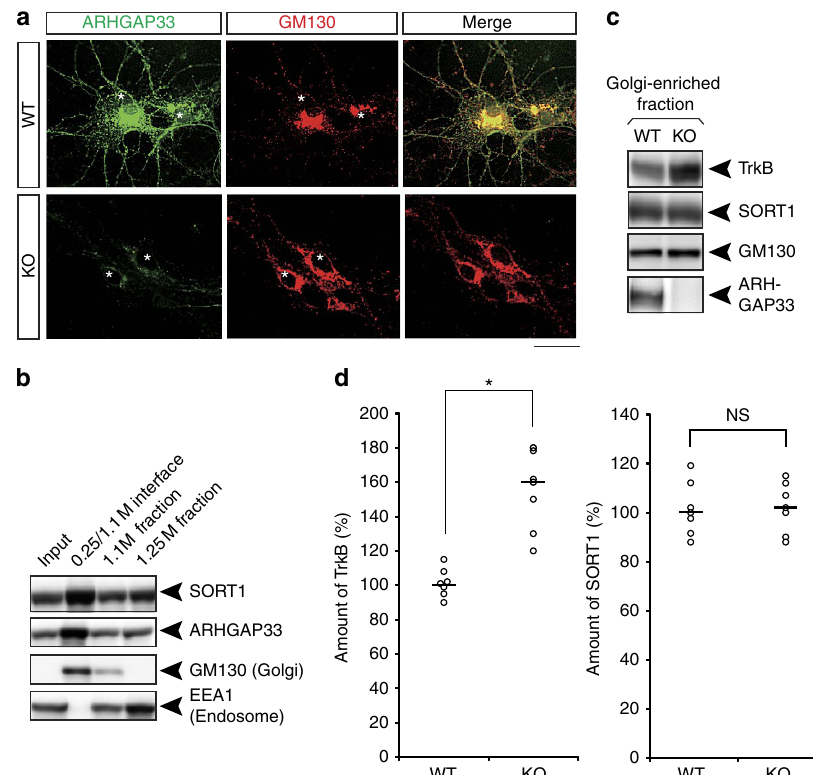
Figure 5 | Increased TrkB at the Golgi apparatus in ARHGAP33 KO mice. ( a ) ARHGAP33 was localized to the Golgi apparatus. Double immunostaining for ARHGAP33 and a Golgi marker, GM130, in dissociated hippocampal neurons. Scale bar, 5 m m. Asterisks indicate the nucleus of neurons. Note that ARHGAP33 immunoreactivity was not detected in the neurons from ARHGAP33 KO mice (lower). The data are representative of three independent experiments. ( b ) ARHGAP33 and SORT1 were co-fractionated with a Golgi marker, GM130. Biochemical preparation of the Golgi membrane fraction from a mouse brain lysate with a discontinuous sucrose density gradient. Equal amounts of protein were loaded into individual lanes and probed with antibodies against SORT1, ARHGAP33, GM130 (a Golgi marker) and EEA1 (an endosomal marker). ( c ) The amount of TrkB, but not SORT1, in the Golgi membrane- enriched fraction was significantly increased in ARHGAP33 KO mice. Equal amount of the Golgi membrane fractions from WTand ARHGAP33 KO mice were probed with anti-TrkB, anti-SORT1, anti-GM130 and anti-ARHGAP33 antibodies. ( d ) Quantification of the amount of TrkB and SORT1 in the Golgi membrane-enriched fraction (each, n ¼ 7, TrkB, P ¼ 0.0017; SORT1, P 4 0.05, Mann–Whitney U -test). The levels of TrkB and SORT1 in the Golgi-enriched fraction from ARHGAP33 KO mice were normalized to those from WT mice (The averaged WT values were set to 100%). * P o 0.05. NS, not significant. Bars show median